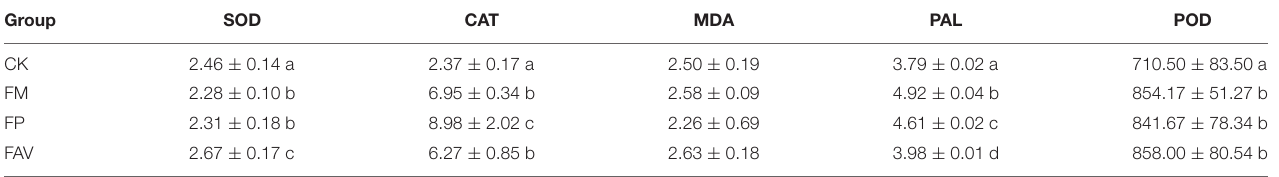
TABLE 3 | Activities of the protective enzymes for potted verification